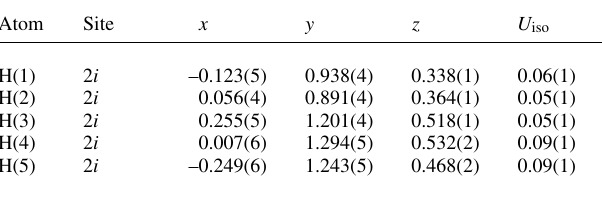
Table 2. Atomic coordinates and displacement parameters (in Å 2 )